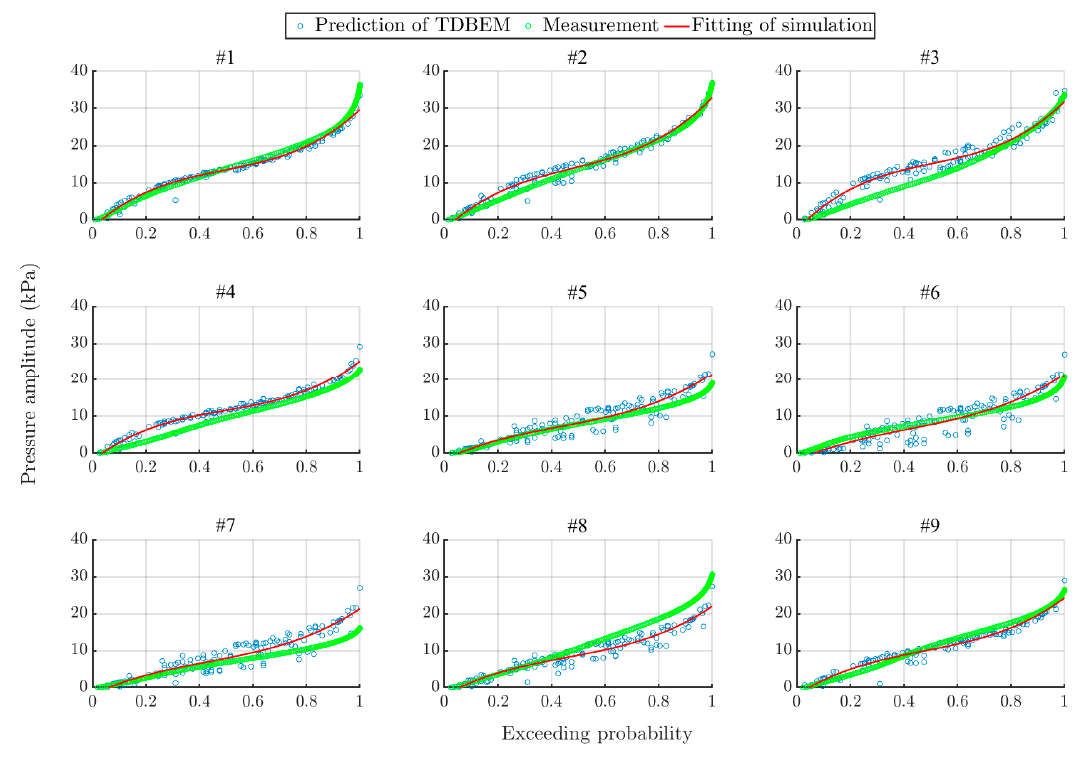
Figure 13. Probability distributions of the pressure amplitude at − 2.37 m.